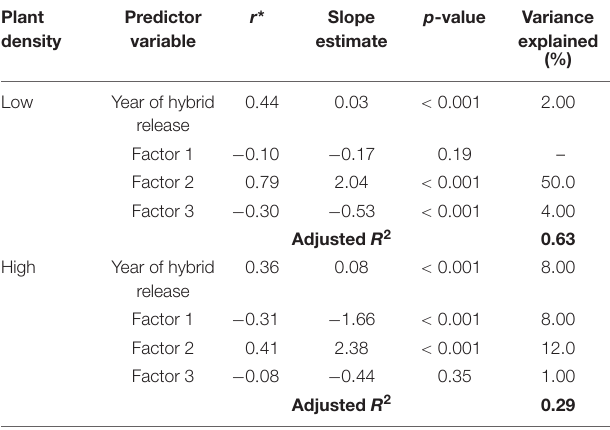
TABLE 4 | Regression parameters for per-area marketable ear mass (Mt/ha) as a response of year of hybrid release (YOR) and factor scores for Low and High plant densities across all sweet corn hybrids at Urbana, IL in